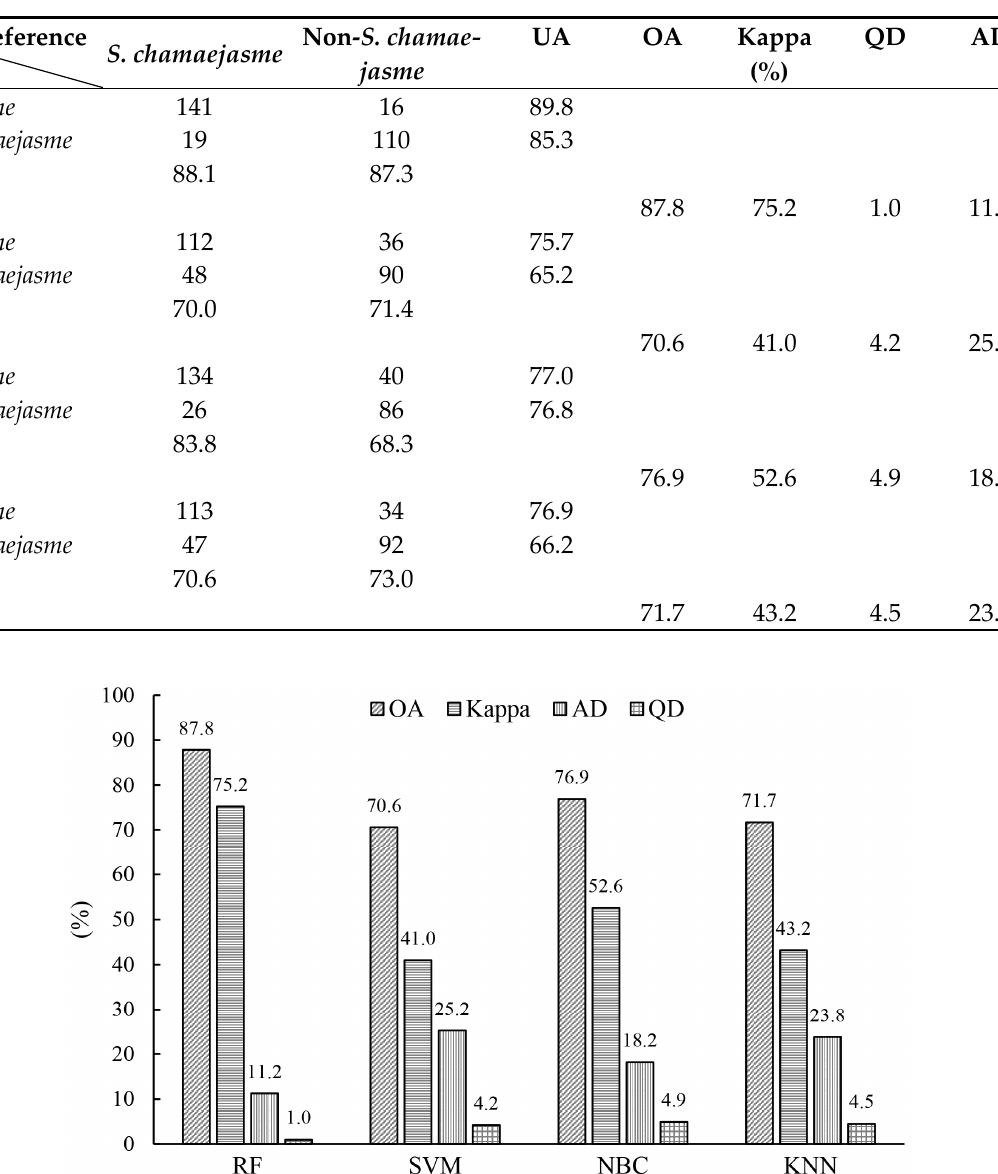
Table 6. Error matrixes of S. chamaejasme classification based on the four algorithms.